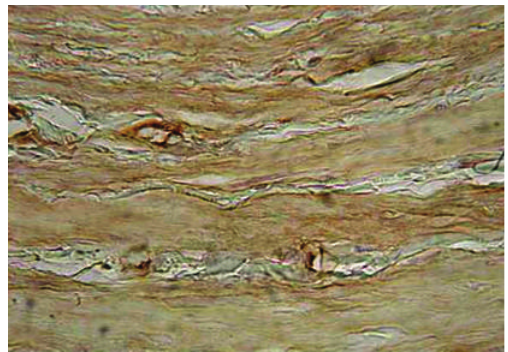
Figure 3: Expression of eNOS in the tunica media of control (healthy) vein (magnification 400x, DAB).